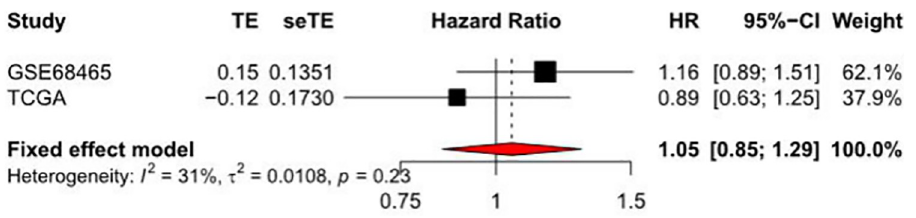
Fig 6. Forest plot of the hazard ratio by COX analysis related to RIOX2 gene in lung adenocarcinoma. The abscissa represents the hazard ratio and the ordinate represents the sample sources.